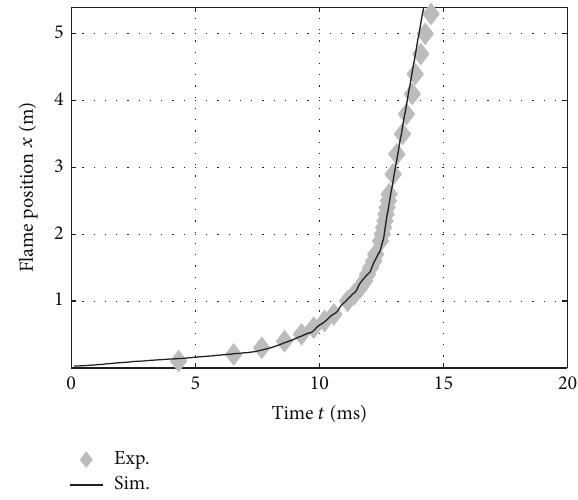
Figure 11: Flame position versus time for a mixture with 25% H 2 (max. concentration